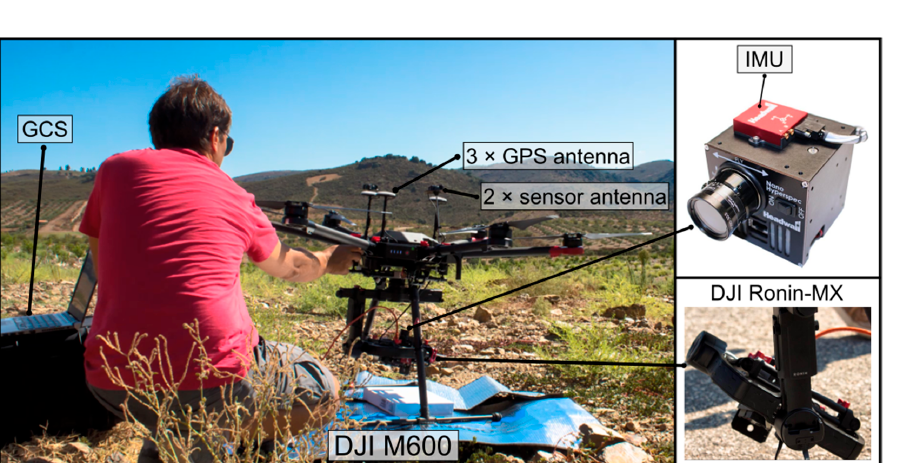
Figure 3. Setup of the DJI Matrice 600 UAV system and Nano-Hyperspectral sensor. The computer on the figure’s left side is used as ground control station (GCS), allowing to control all mission’s operations.